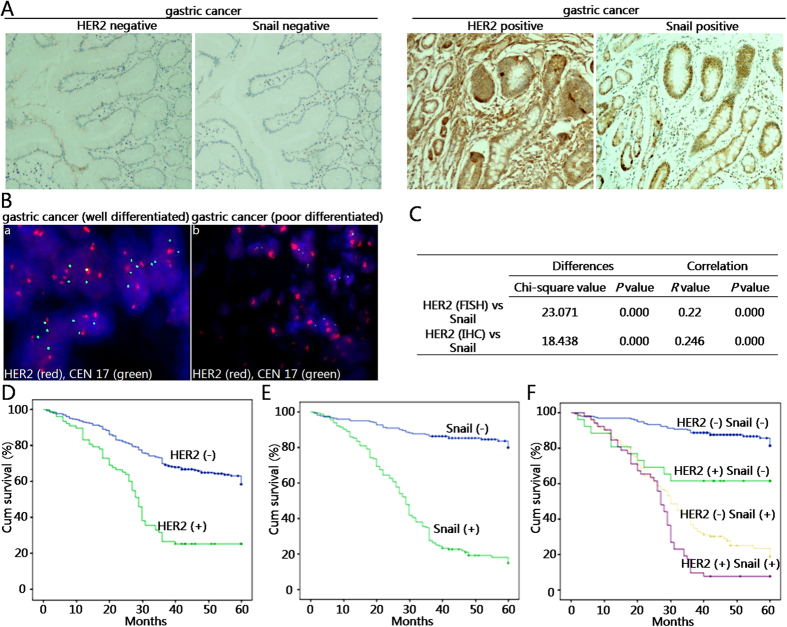
HER2/Snail double positive gastric cancer patients have unfavorable outcome.(A) Representative immunohistochemical staining of HER2 and Snail by respective antibody in human gastric tissues. Original magnification, 100 × . (B) Representative FISH staining of HER2 by probe in human gastric tissues. Original magnification, 400 × . HER2 amplification was determined as a ratio of HER2 (red dots) and chromosome 17 centromere (green dots) signal counts. Ratios < 2 were determined as no amplification with FISH, and those >2 as positive amplification with FISH. “a” represents no amplification; “b” represents positive amplification. (C) Chi-square analysis of the correlation of HER2 expression or amplification with Snail expression. (D) Kaplan-Meier Curve analysis of HER2 amplification with OS for patients with gastric cancer by the log-rank test. (E) Kaplan-Meier estimation of Snail overexpression with OS for patients with gastric cancer by the log-rank test. (F) Kaplan-Meier estimation of HER2/Snail double positive expression versus single positive or both negative counterparts with OS for patients with gastric cancer by the log-rank test.